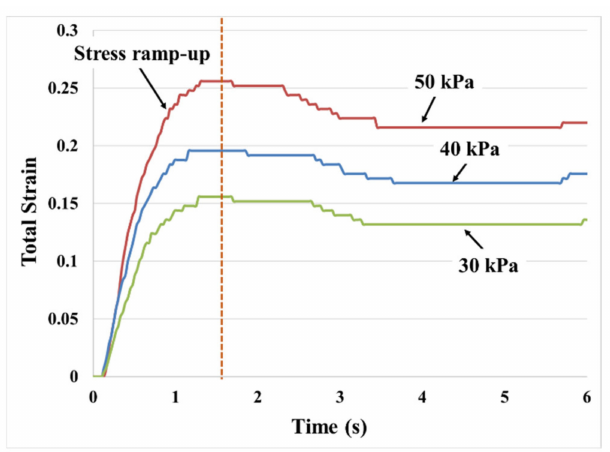
Figure 11. Creep stress ramps up to the pre-set steady-state value within the first 3 s of the creep test and is then held constant for the duration of the creep test (130 µ m thick